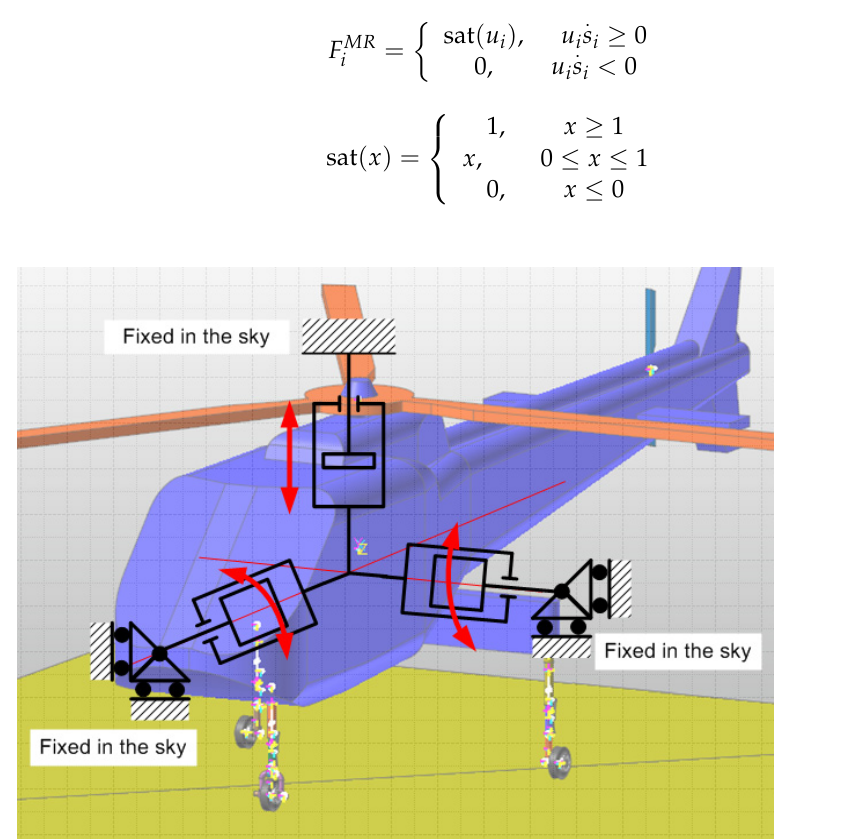
Figure 8. Concept of skyhook extended control for the helicopter with 3 landing gears.